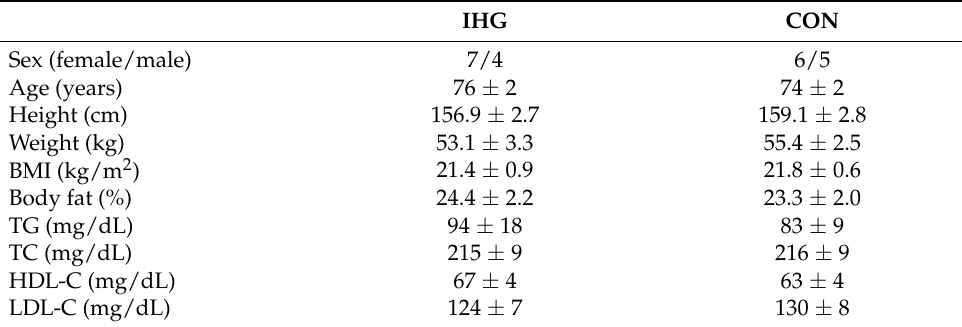
Table 1. Participants’ characteristics and serum lipids profile at